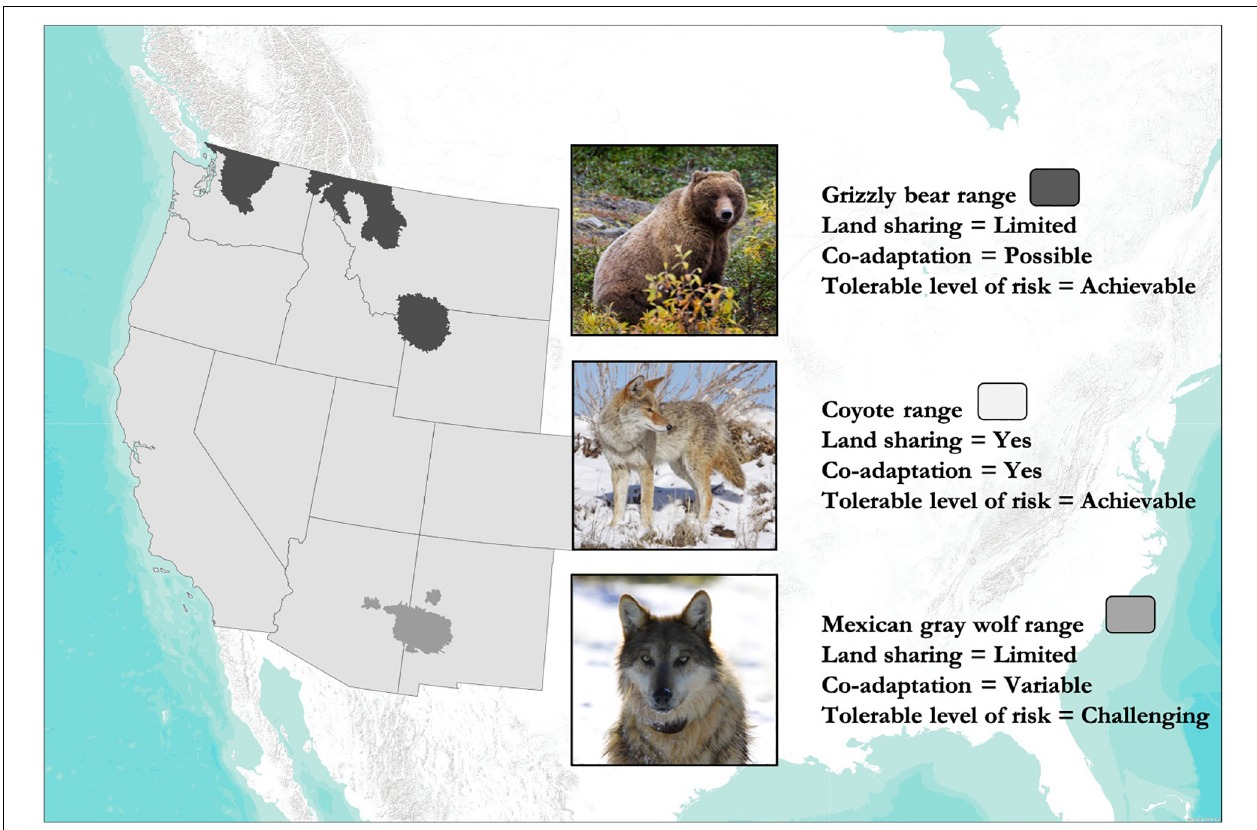
FIGURE 1 | Map of the American West and case study species. Within the conterminous United States, grizzly bears currently range in Idaho, Montana, Washington, and Wyoming. Their geographic range extends into Canada but is not shown here. Mexican gray wolves are currently in Arizona and New Mexico, as well as Mexico (not shown). Coyotes range across the 11 western United States and beyond. Mexican gray wolf photo courtesy of United States Fish and Wildlife Service. Grizzly bear and coyote photos from member skeeze on Pixabay.com. Range data from: United States Geological Survey – Gap Analysis Project, 2018, United States Geological Survey – Gap Analysis Project Species Range Maps CONUS_2001: United States Geological Survey data release,